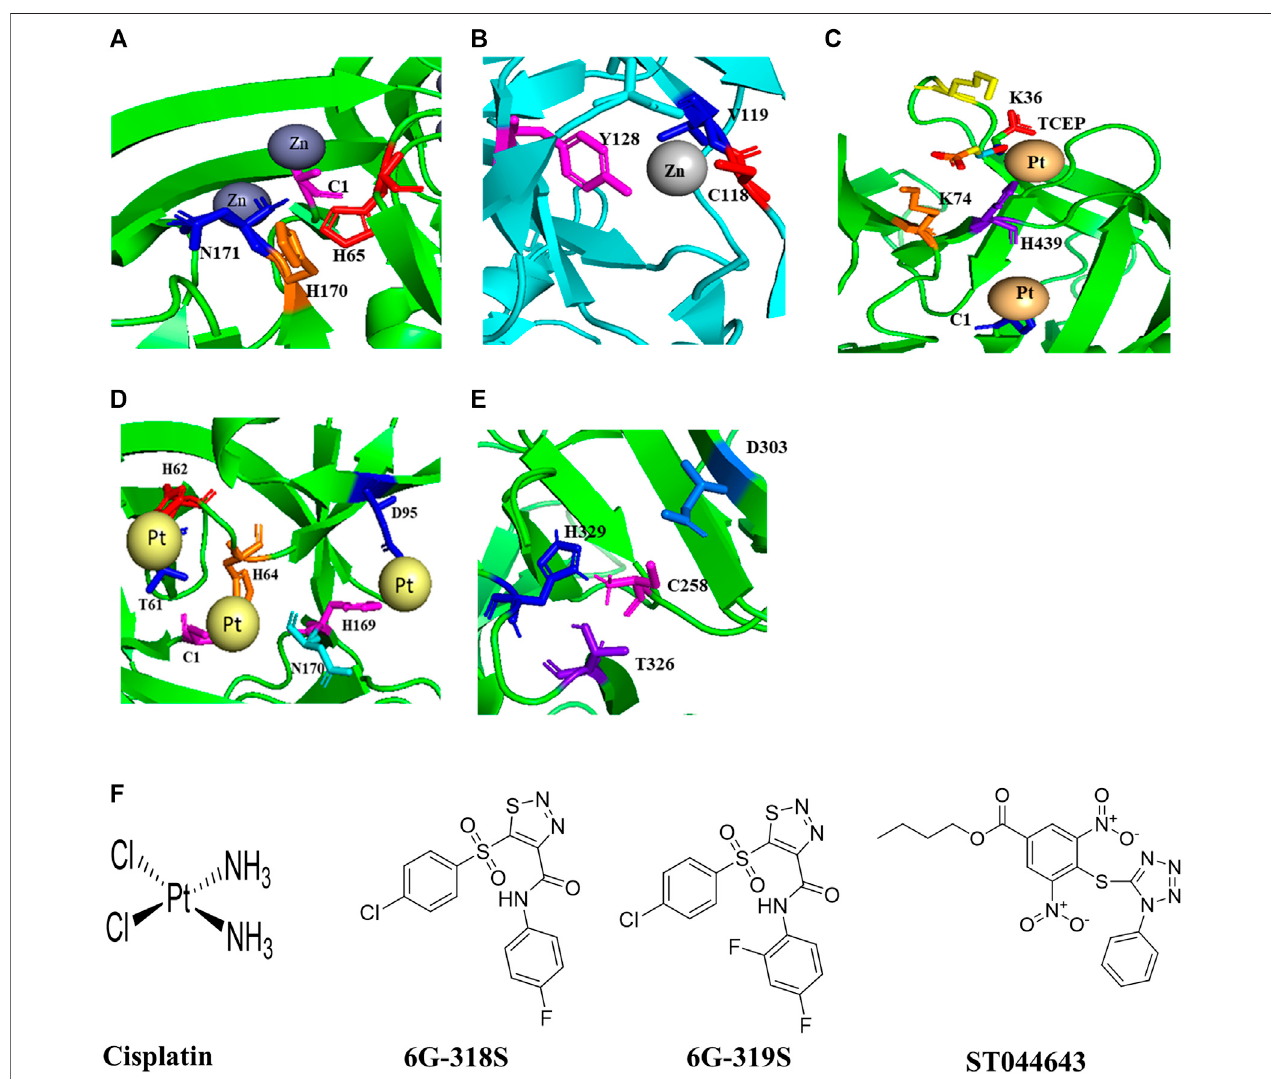
FIGURE 1 | Structures of inteins, intein-ligand complexes, and small molecule inhibitors of intein splicing and hedgehog cholesterolysis. (A) The Prp8 intein of C. neoformans and Zn 2+ (Greenet al., 2019). (B) The DnaBi1 intein of M. smegmatis and Zn 2+ (Woodset al.,2020). (C) ,The RecA inteinof M.tuberculosis in complex with platinumand TCEP(Chanet al.,2016). (D) ThePrp8 inteinof C.gattii and cisplatin (Liet al.,2019). (E) TheC-terminal17 kDafragmentofdrosophila hedgehogshowing catalytic residues in cholesterolysis (Hall et al., 1997). (F) Structures of small molecules that inhibit intein splicing and hedgehog cholesterolysis.